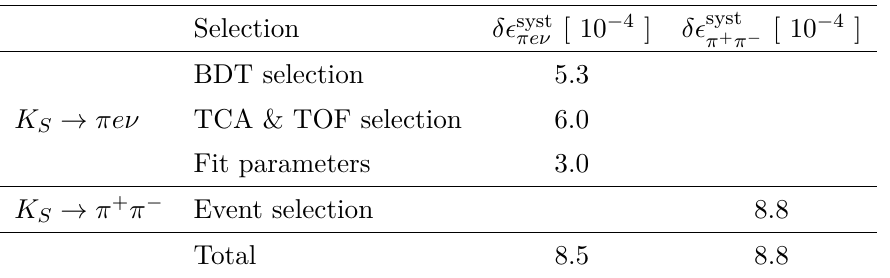
Table 6 . Absolute systematic